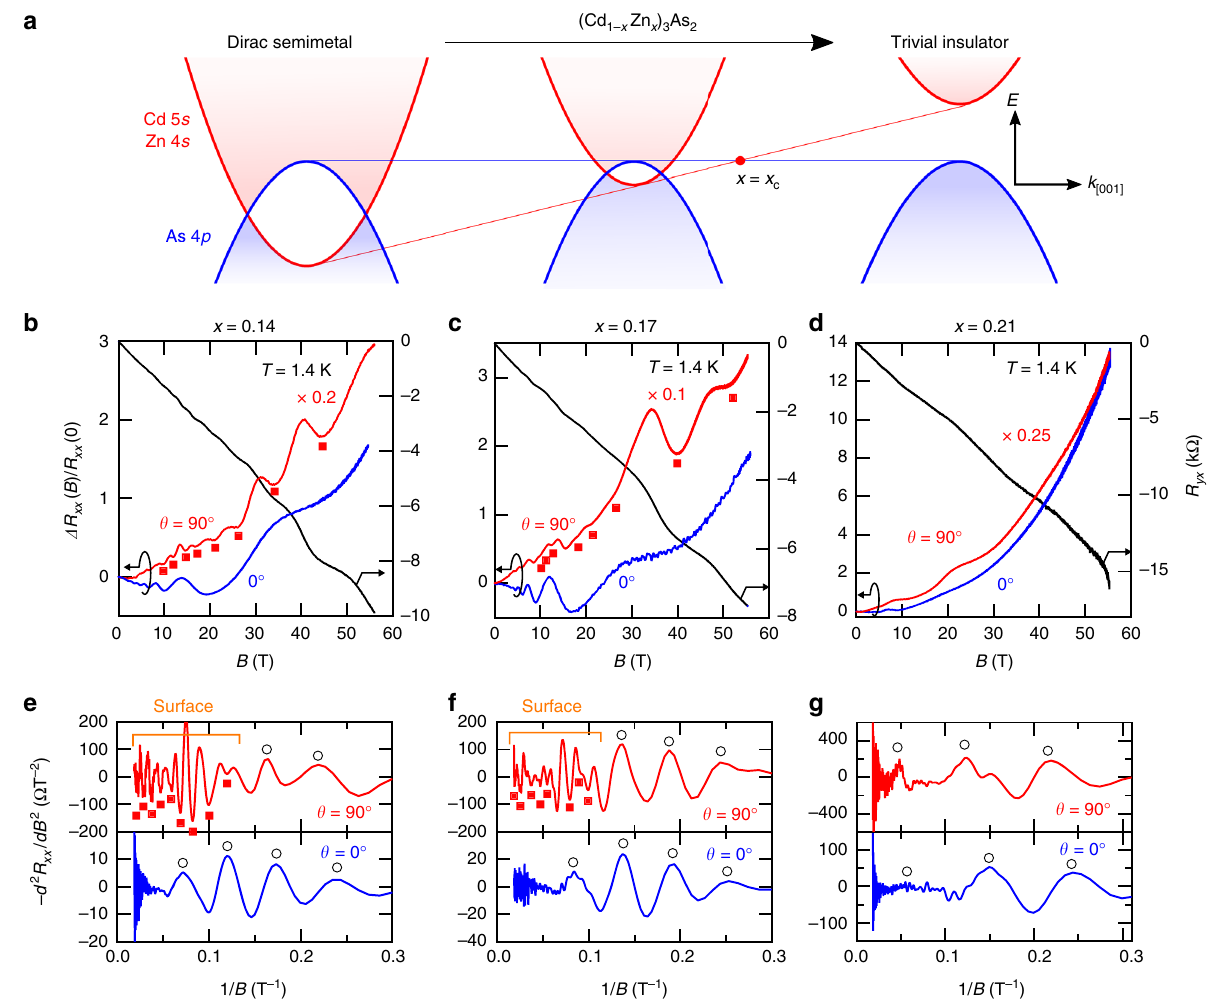
Fig. 2 Evolution of the surface transport through topological phase transition. a Zn-doping-induced topological phase transition from a Dirac semimetal (DSM) to a trivial insulator in (Cd 1 − x Zn x ) 3 As 2 . b – d Transverse and longitudinal magnetoresistances (MRs) of (Cd 1 − x Zn x ) 3 As 2 fi lms with different Zn concentrations ( x = 0.14, 0.17, and 0.21). e – g Second derivative of the MRs plotted as a function of 1/ B . In addition to the bulk oscillations (open circles), an additional oscillation component ( fi lled squares) is observed only for x = 0.14 and 0.17, indicating the disappearance of the surface state for x = 0.21,